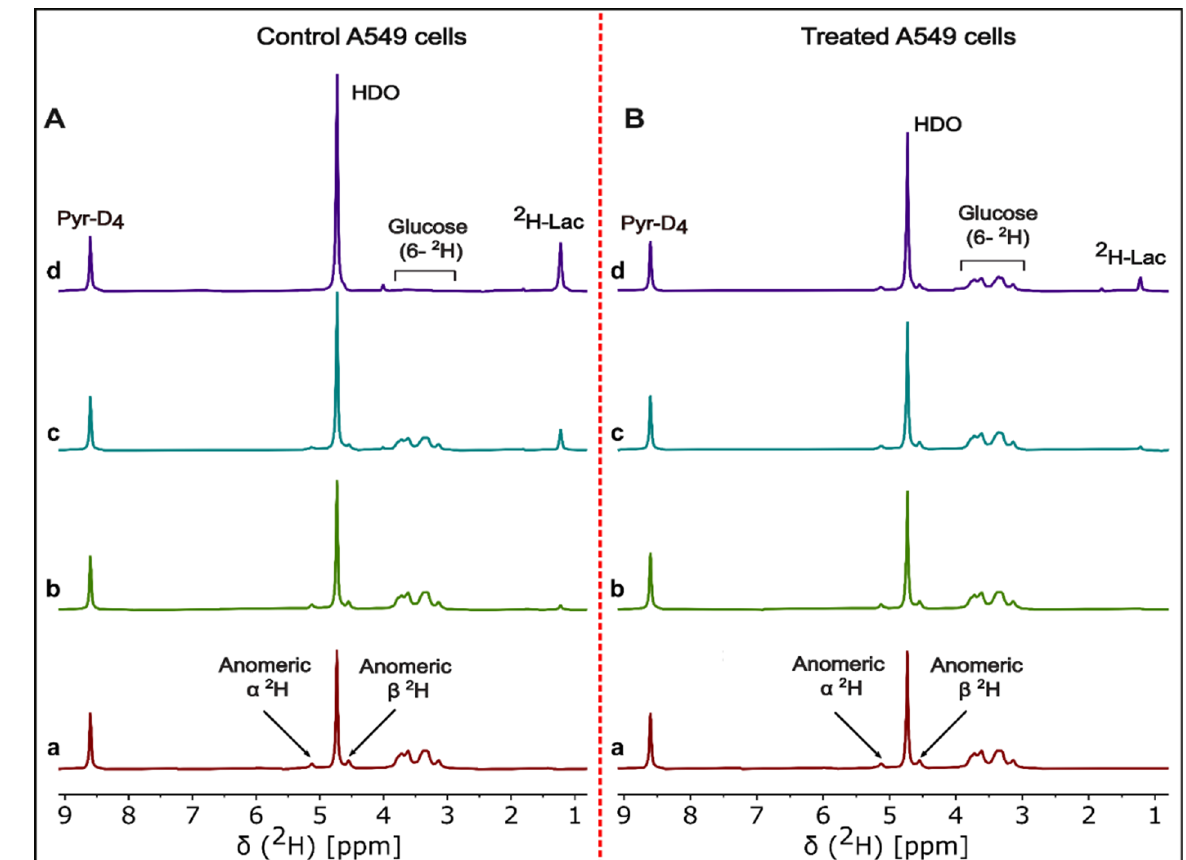
Figure 1. Representative 2 H-NMR spectra of cell media time course analysis. Stacked plot of 2 H-NMR spectra of DMSO control (left, panel A ) and β -lapachone treated (right, panel B ) of the A549 cell line incubated with 5.5 mM [ 2 H 7 ]glucose. Cell media samples were withdrawn at ( a ) 0 min, ( b ) 30 min, ( c ) 2 h, and ( d ) 6 h incubation time points of the β -lapachone post-treatment cultures of A549 cancer cells. Labeling in the (a and d) spectra of panel A , B shows the signals for pyrazine-D 4 , HDO, residual [ 2 H 7 ]glucose, and 2 H-lactate.